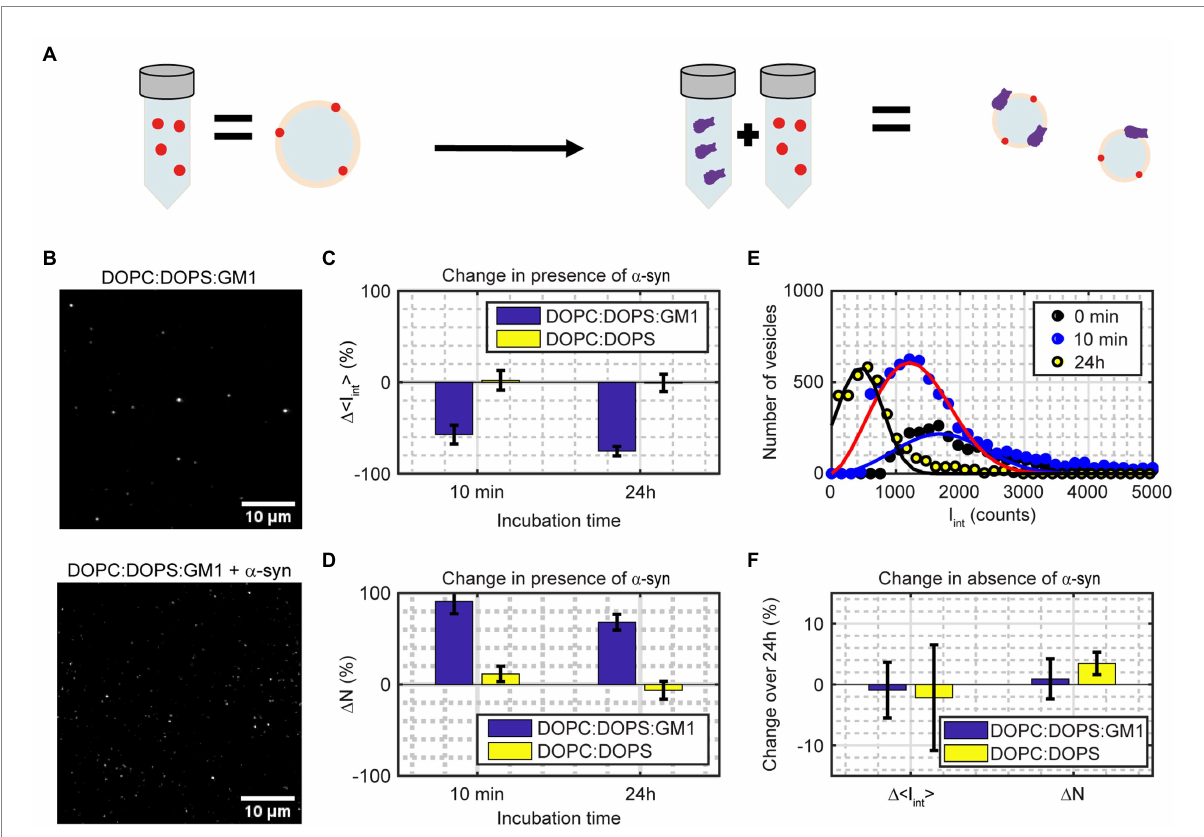
FIGURE 7 (A) Illustration of the measurement. Mixing a sample of fluorescently labeled vesicles containing 10 mol% GM1 with α -syn results in more vesicles but with lower intensity per vesicle. (B) Image of samples in absence (top) and presence (bottom) of α -syn. The scale bars are 10 μ m. (C,D) Relative changes in integrated intensity ( Δ < I int >; Eq. 3) and number of vesicles ( Δ N) for vesicles containing DOPC:DOPS:GM1 (7:2:1) and DOPC:DOPS (7:3) incubated with α -syn compared to vesicles without α -syn. The data correspond to mean ± SD from n = 4 measurements. (E) I int (Eq. 3) population distribution from one representative measurement for DOPC:DOPS:GM1 vesicles either without α -syn incubation (0 min; black circles), 10 min α -syn incubation (blue circles) or 24 h α -syn incubation (yellow circles). The solid lines are fits to a Weibull distribution. (F) Change in integrated intensity ( Δ < I int >) and number of vesicles ( Δ N) for DOPC:DOPS:GM1 and DOPC:DOPS vesicles over 24 h in absence of α -syn. The data correspond to mean ± SD from n = 3–4